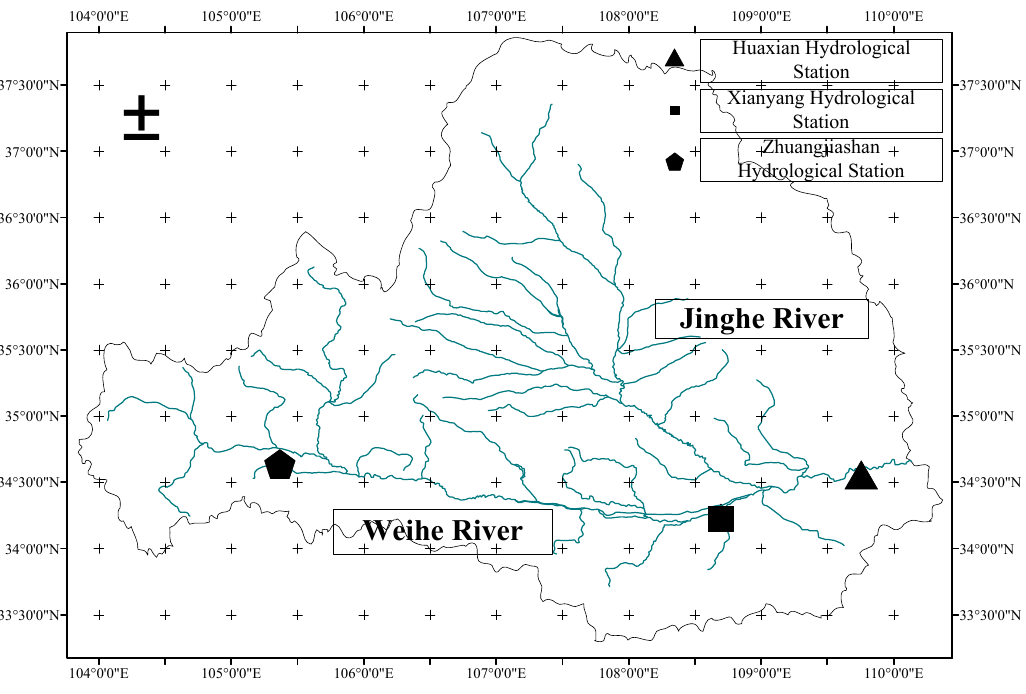
Figure 1. Location of hydrological stations in Weihe River.